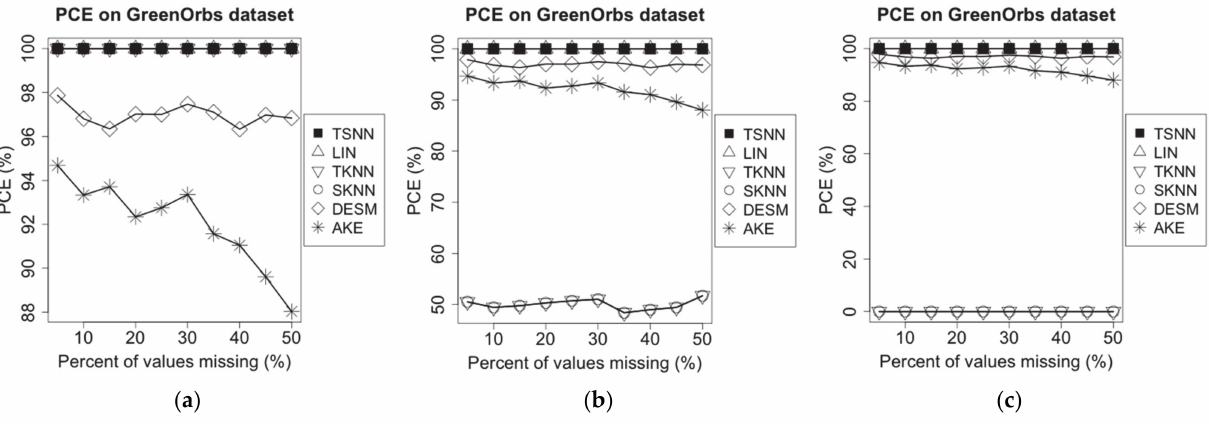
Figure 6. PCE of different algorithms on GreenOrbs dataset for the three scenarios: ( a ) temperature NA and humidity not NA, ( b ) temperature NA and humidity 50% NA and ( c ) temperature NA and humidity